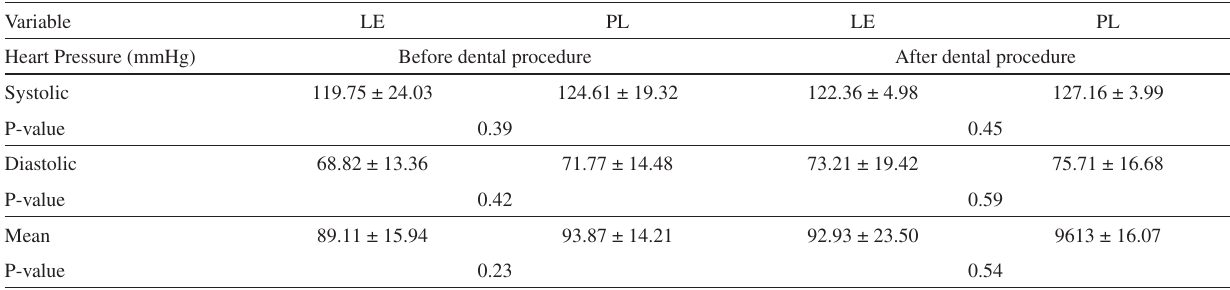
Table 2 - Values (mean ± SD) for systolic, diastolic and median blood pressure, before and after dental procedure in the PL and LE